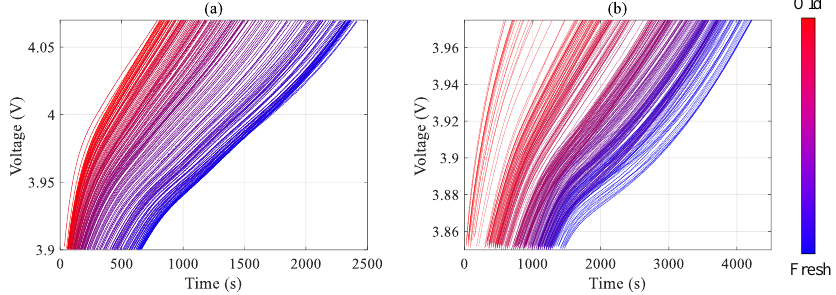
Figure 5. The voltage curves corresponding to 10 – 50% SOC: ( a ) NASA; ( b ) CALCE.